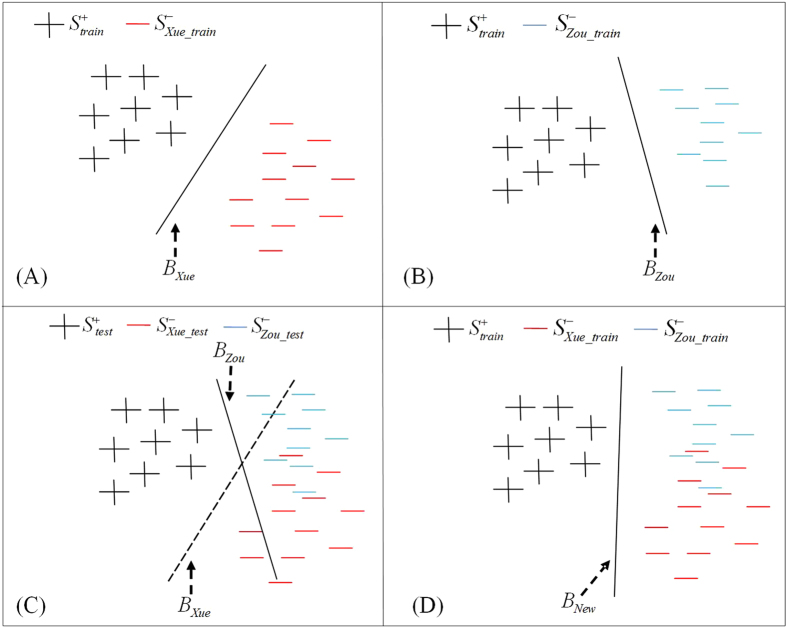
Importance of negative sample distribution for a SVM classifier decision boundary.Bxue is the generated decision boundary based on  and ; Bzou is the generated decision boundary based on  and ; BNewis the generated decision boundary based on ,  and .